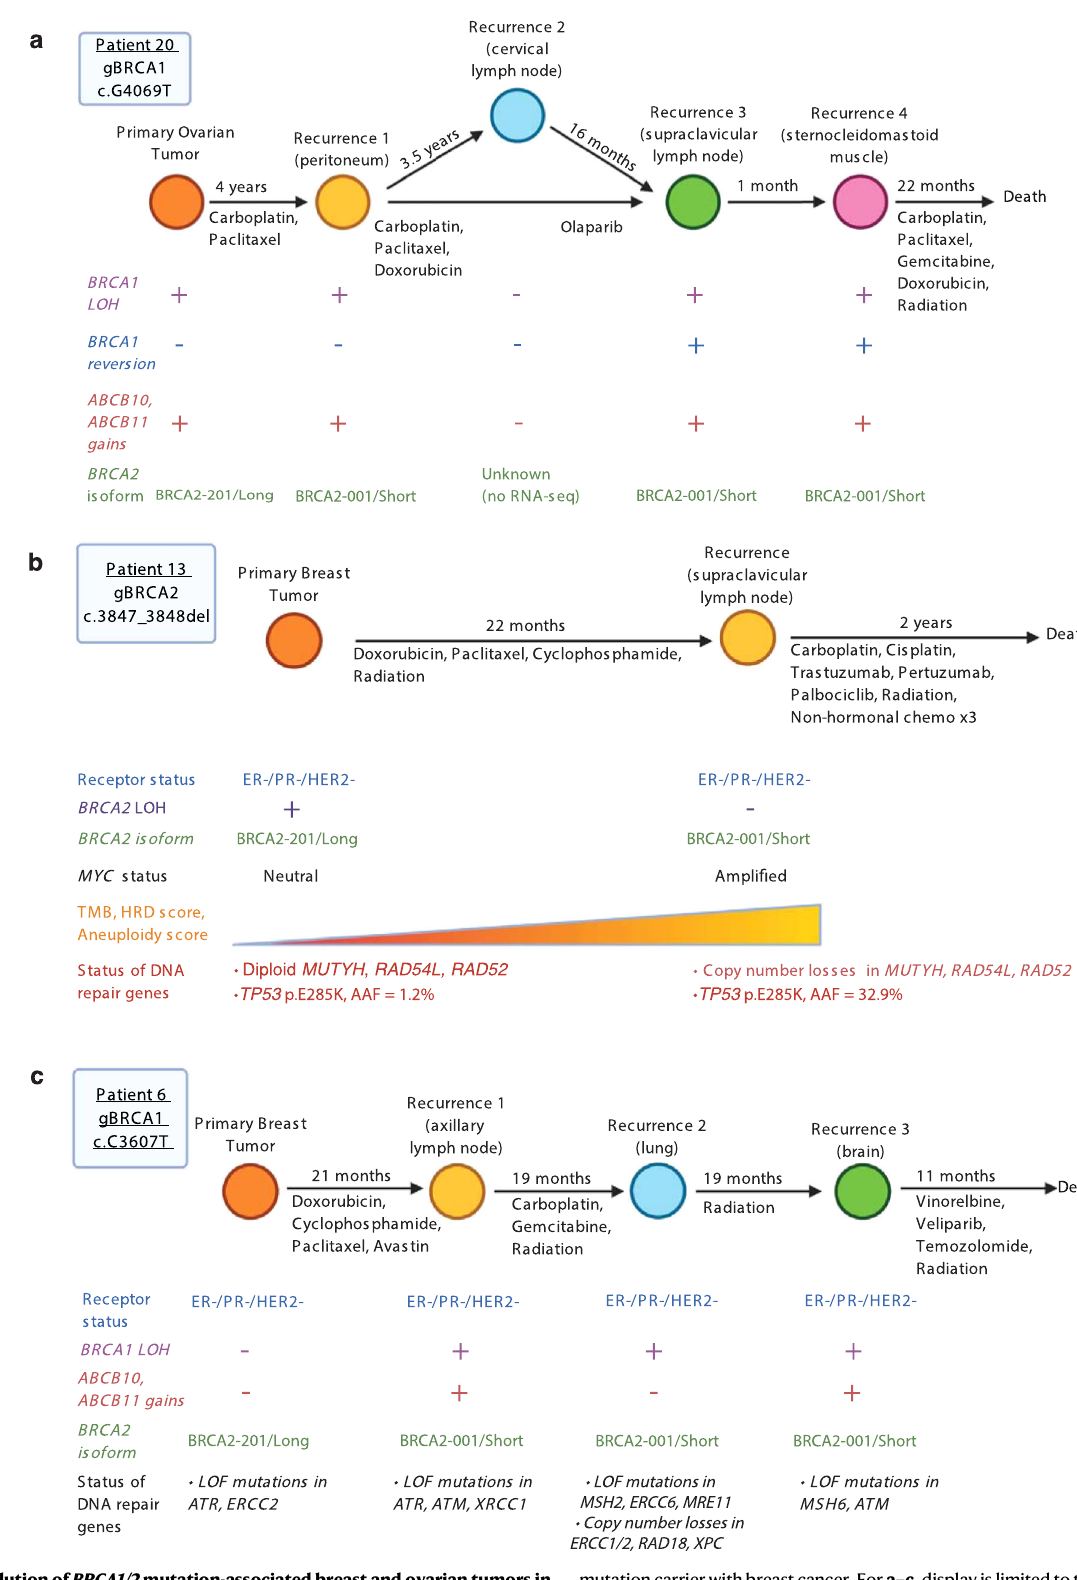
mutationcarrierwithbreastcancer.For a – c ,displayislimitedtotumorssequenced forthis study. Copy number losses referto geneswith totalcopynumber of 0 or 1; copynumbergainsrefertogeneswithtotalcopynumber ≥ 4.Lossoffunction(LoF) mutations reported here are from high-depth targeted